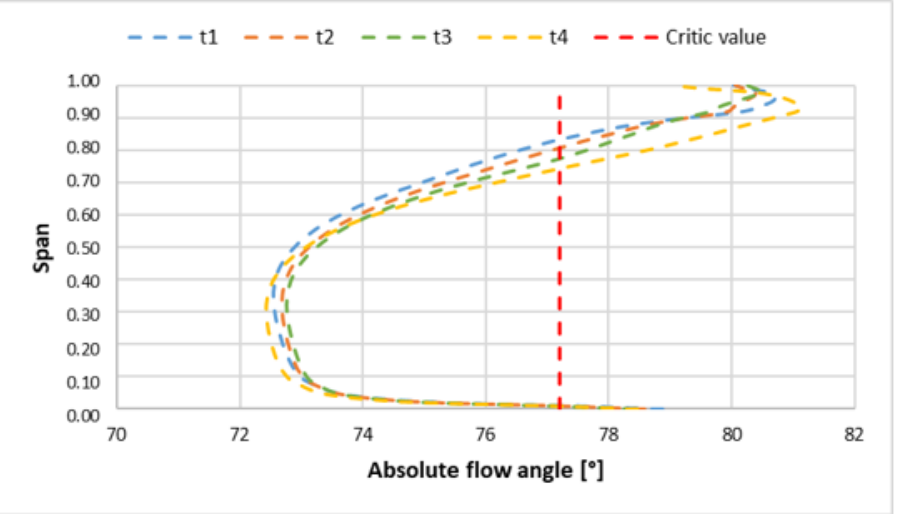
Figure 21. Hub-to-shroud distributions of the absolute flow angle at the diffuser inlet obtained with the fully 3D unsteady model baseline at the condition OP3, for several instants.